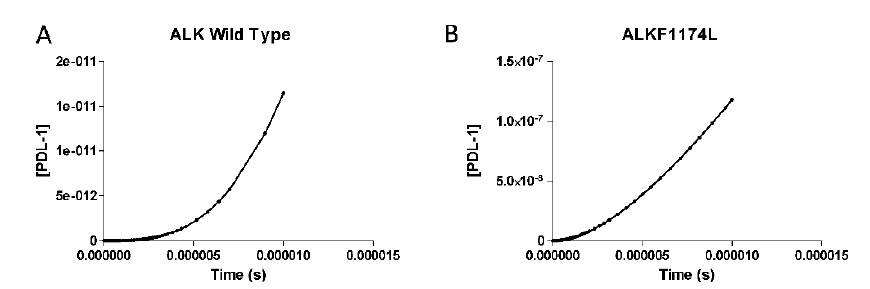
Figure 3. Expression of PD-L1 in a neuroblastoma cell line without ALK mutations ( A ). PD-L1 expression in a neuroblastoma cell line harboring ALKF1174L mutation ( B ). The simulation was conducted from 0 s to 1 × 10 −5 s, using the deterministic (LSODA) method. All concentrations are in mmol / mL.